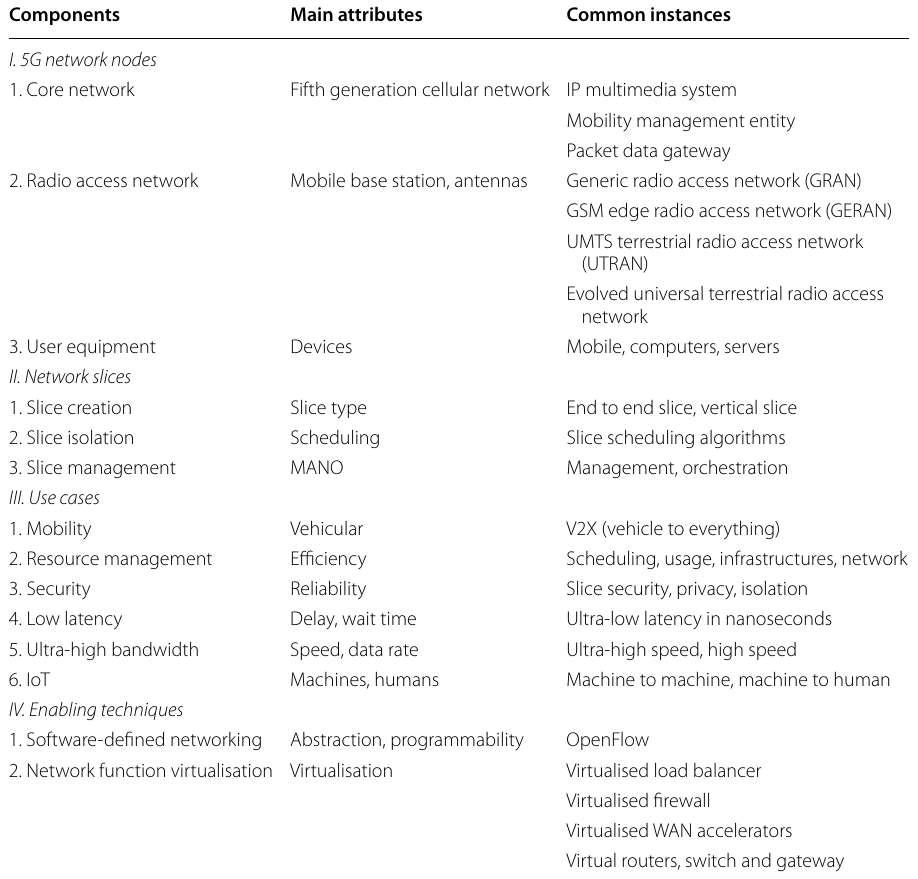
Table 1 5G-NSUE proposed system components